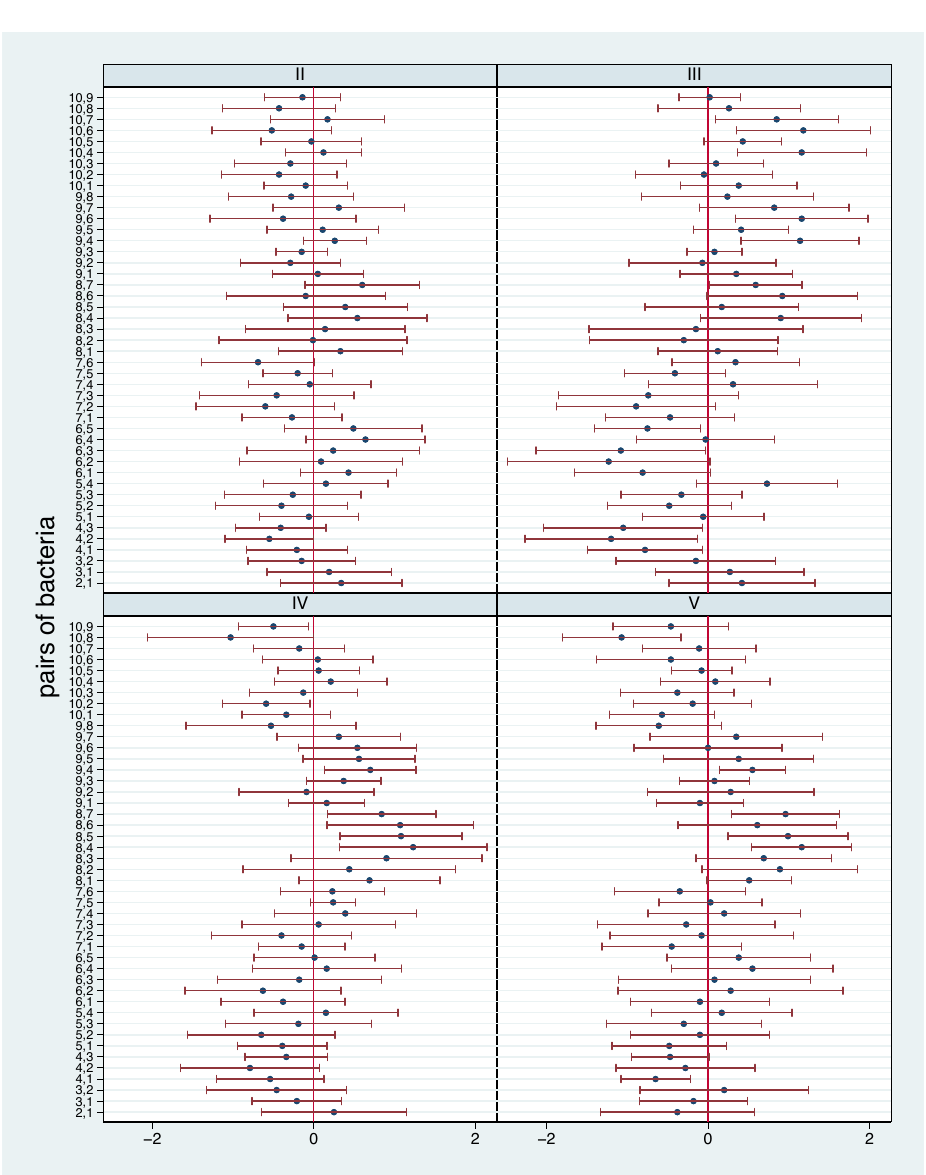
Figure 6. Mean log ratio changes for all bacterial pairs for phases II–V with 95% confidence